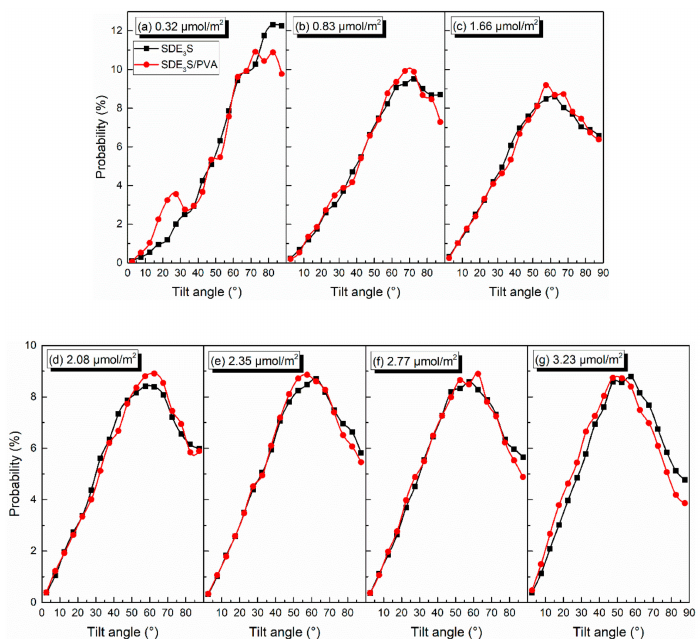
Figure 13. Comparison of tilt angles of θ tail in SDE 3 S and SDE 3 S / PVA systems: ( a ) 0.32 µ mol / m 2 ; ( b ) 0.83 µ mol / m 2 ; ( c ) 1.66 µ mol / m 2 ; ( d ) 2.08 µ mol / m 2 ; ( e ) 2.35 µ mol / m 2 ; ( f ) 2.77 µ mol / m 2 ; ( g ) 3.23 µ mol / m 2